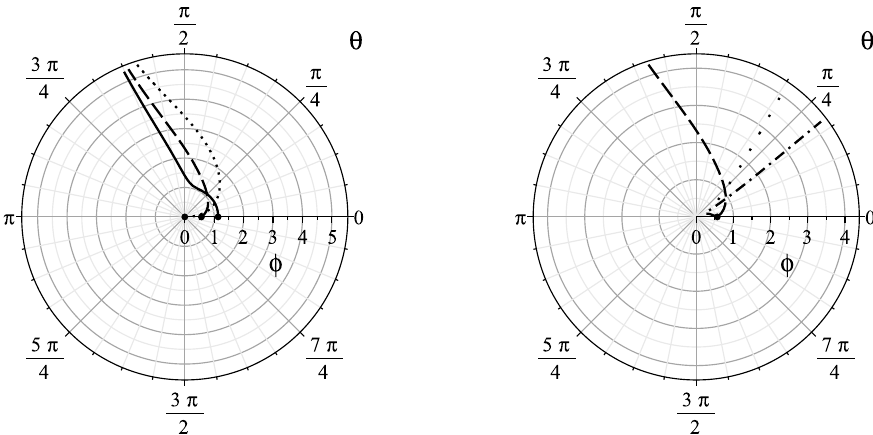
Figure 7 . The trajectories of (cid:12)gure 6 in polar ( ’; (cid:18) ) coordinates.